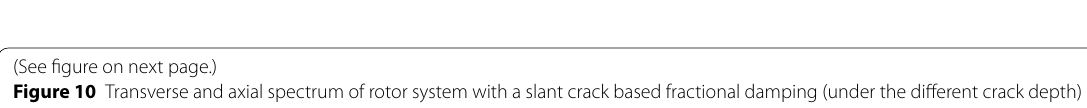
depth)(See figure on next Figure 10 Transverse and axial spectrum of rotor system with a slant crack based fractional damping (under the different crack